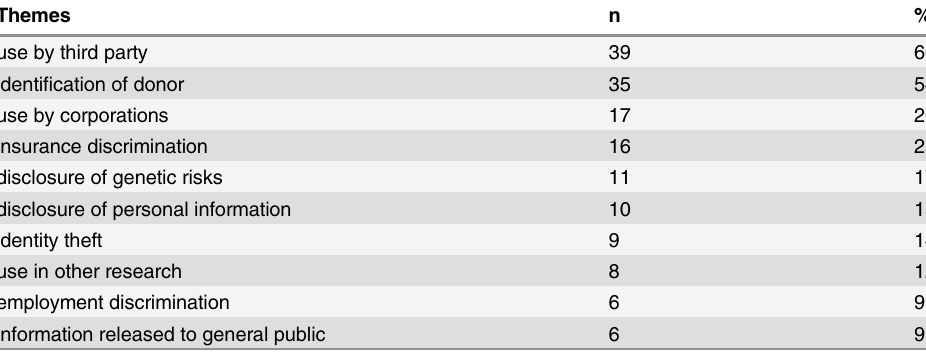
Table 6. Top 10 Themes in Risks Respondents Identified with a Confidentiality